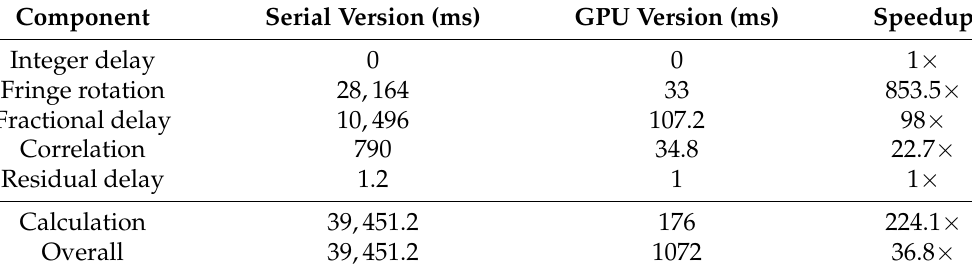
Table 3. The comparison between GPU version and serial